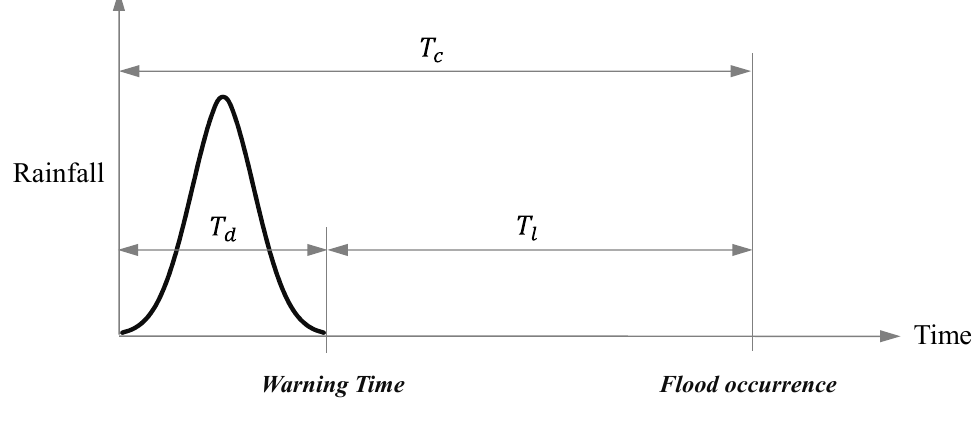
Figure 3. The relationship between concentration time T c , rainfall duration T d , and lead time T l in flood